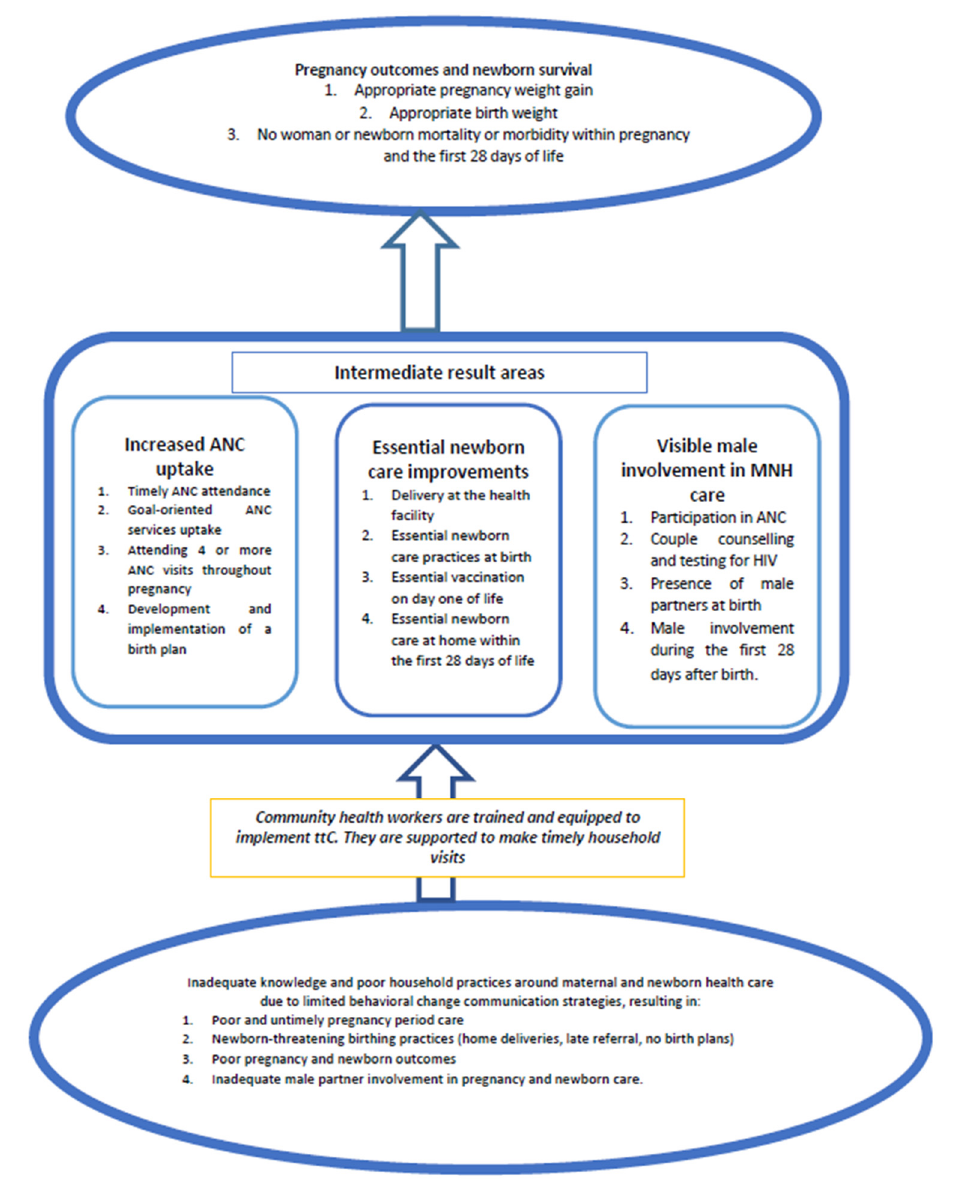
Figure 1. Conceptual framework. MNH—maternal and newborn health, ANC—antenatal care, ttC—timed and targeted counselling.